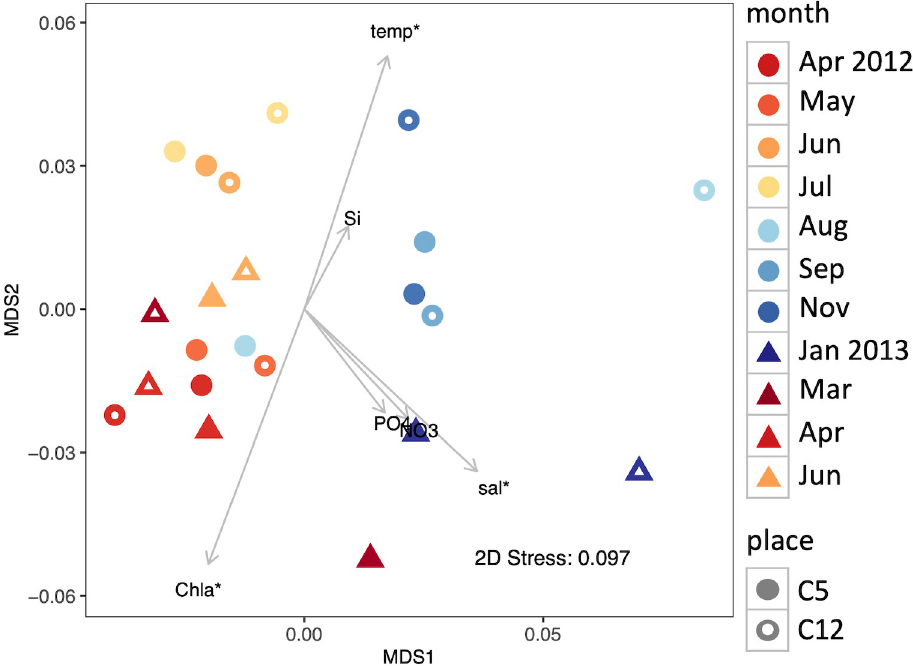
Fig 4. Nonmetric multidimensional scaling (nMDS) plot of KEGG pathway composition of non-cyanobacterial prokaryotic sequences. Environmental variables are fitted as vectors on the plot; arrow lengths are scaled based on the squared correlation coefficients and the asterisks indicate significant correlations (p < 0.05) with the nMDS ordination.